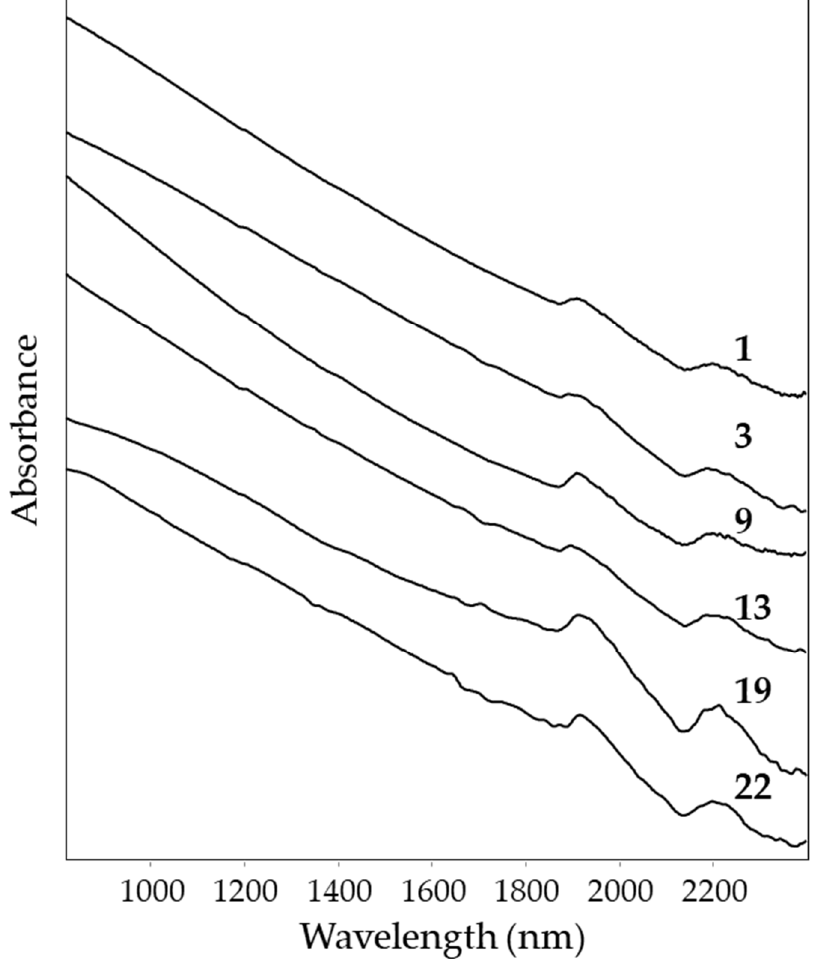
Figure 7. NIR reflectance spectra obtained on powders of some bucchero samples, identified as locally produced (9, 13, 22) or imported (1, 3, 19) on the basis of elemental analysis, from the excavation of La Civita di Tarquinia.